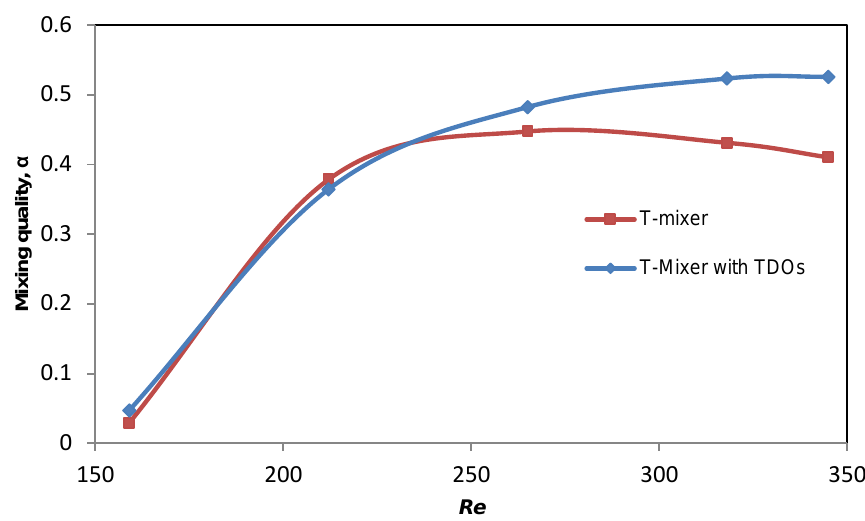
Figure 13. Variation of mixing quality with Re number